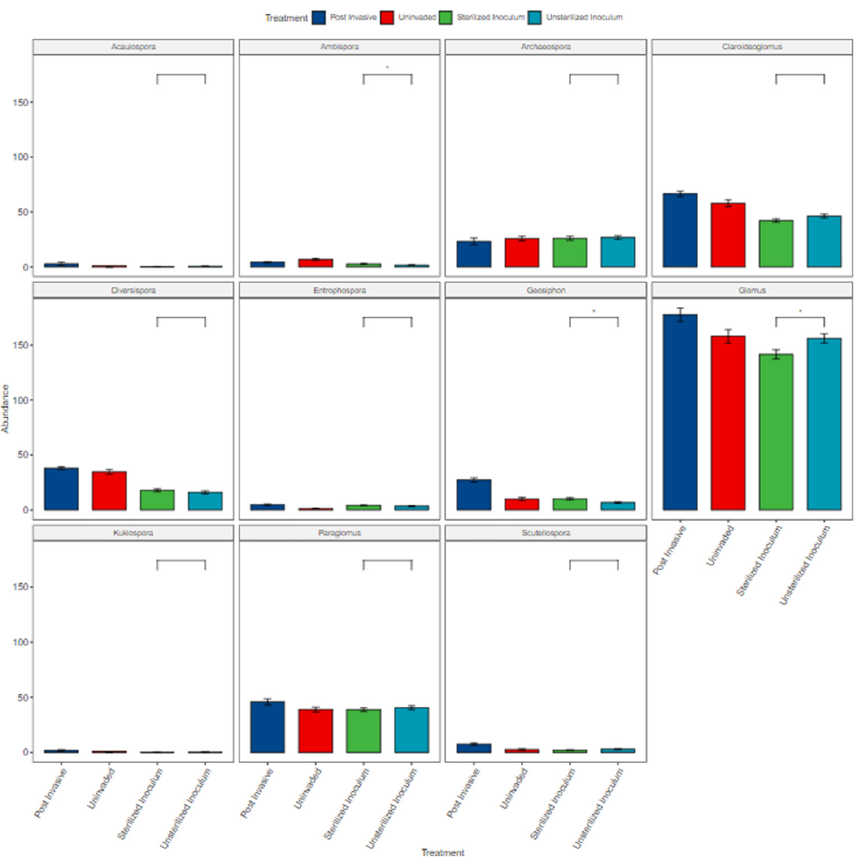
Figure 4. Relative abundances of genera (Acaulospora, Ambispora, Archaeospora, Claroideoglomus, Diversispora, Entrophospora, Geosiphon, Glomus, Kuklospora, Paraglomus, and Scutellospora). Three were significantly different between treatment plots. Standard errors are represented in the figure by the error bars attached to each column (ns, not significant; ‘‘*’’, p < 0.05; ‘‘**’’, p < 0.01; ‘‘***’’, p < 0.001; ‘‘****’’, p < 0.0001).